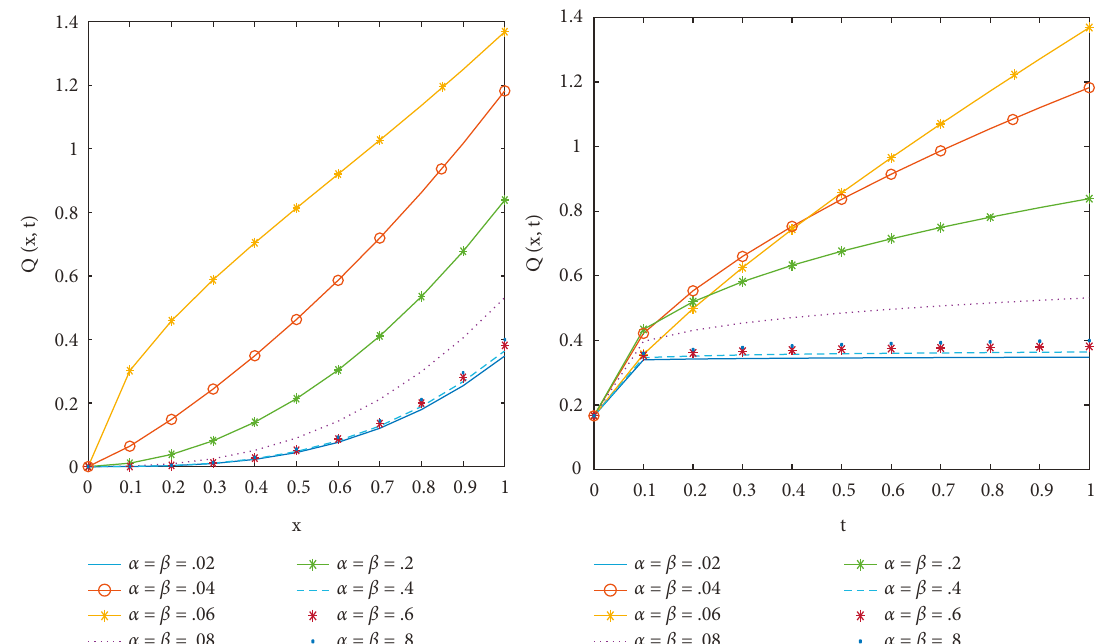
Figure 4: Comparison of the solution at various values of alpha and